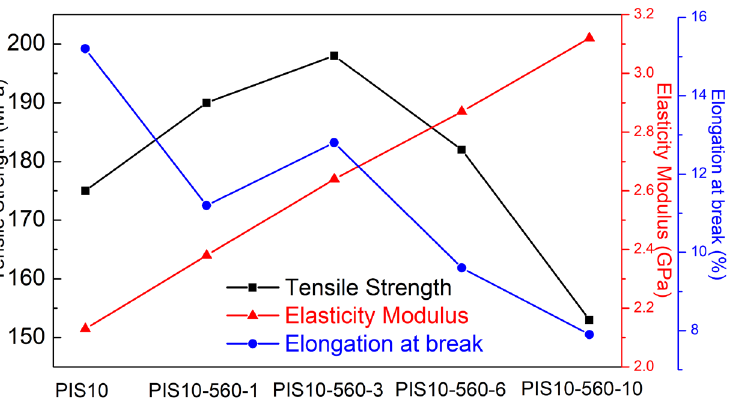
Figure 4. The mechanical properties of PIS10, PIS10-560-1, PIS10-560-3, PIS10-560-6 and